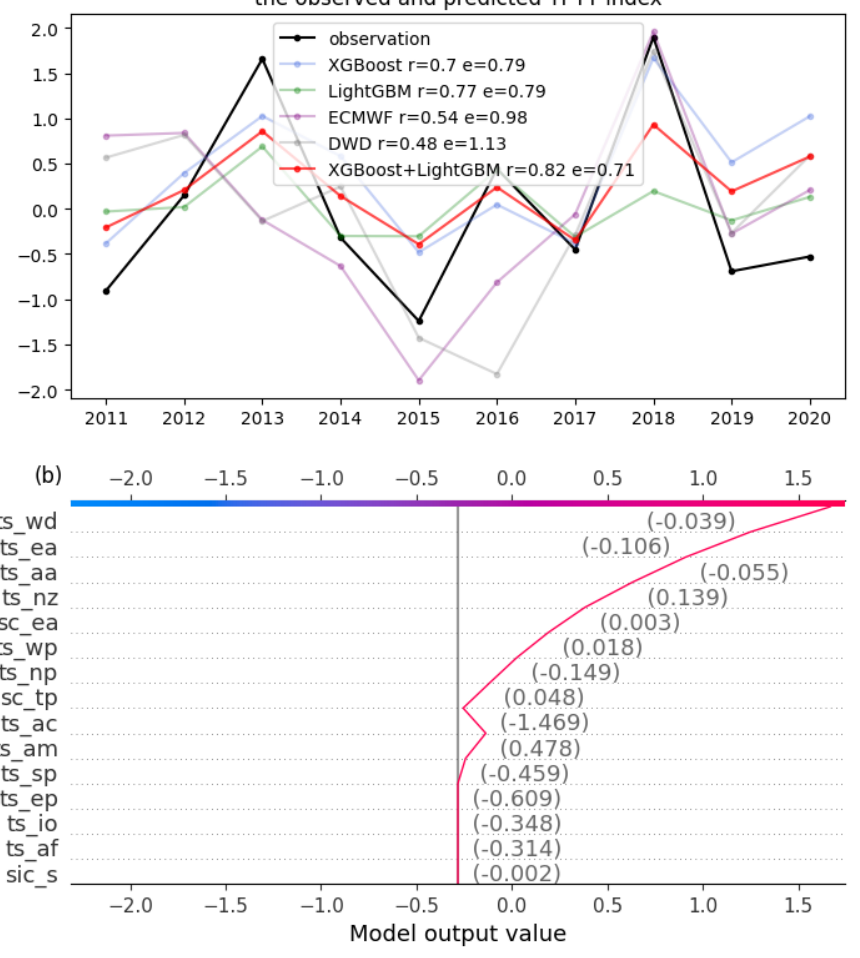
Figure 3. The observed and predicted TPTT index by using the boreal spring initial fields. The r and e values represent the DCORR and RMSE between the prediction and the observation, respectively ( a ); The decision routine of the TPTT index in 2018 by using XGBoost. The vertical coordinate of ( b ) is the feature importance ranking, with decreasing importance from top to bottom, and the values next to the curve are the corresponding feature values. The upper end of the curve is the final prediction for 2018 ( b